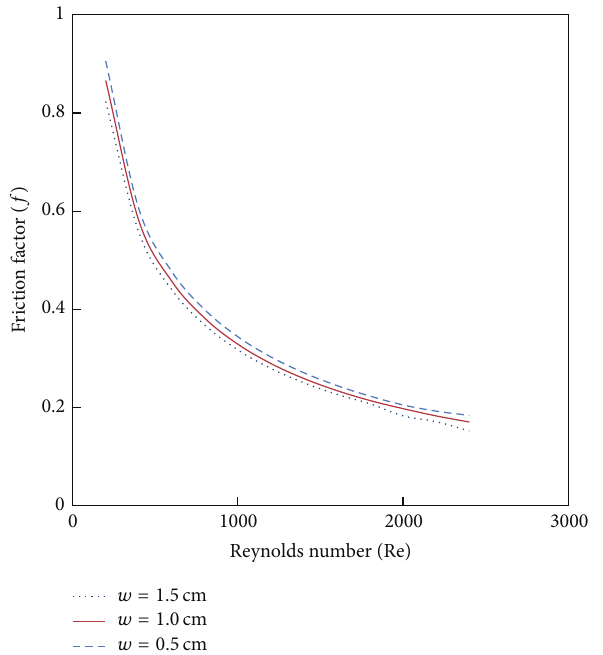
Figure10:Theeffectofcutdepthwith4%CuOnanofluidonfriction factor.